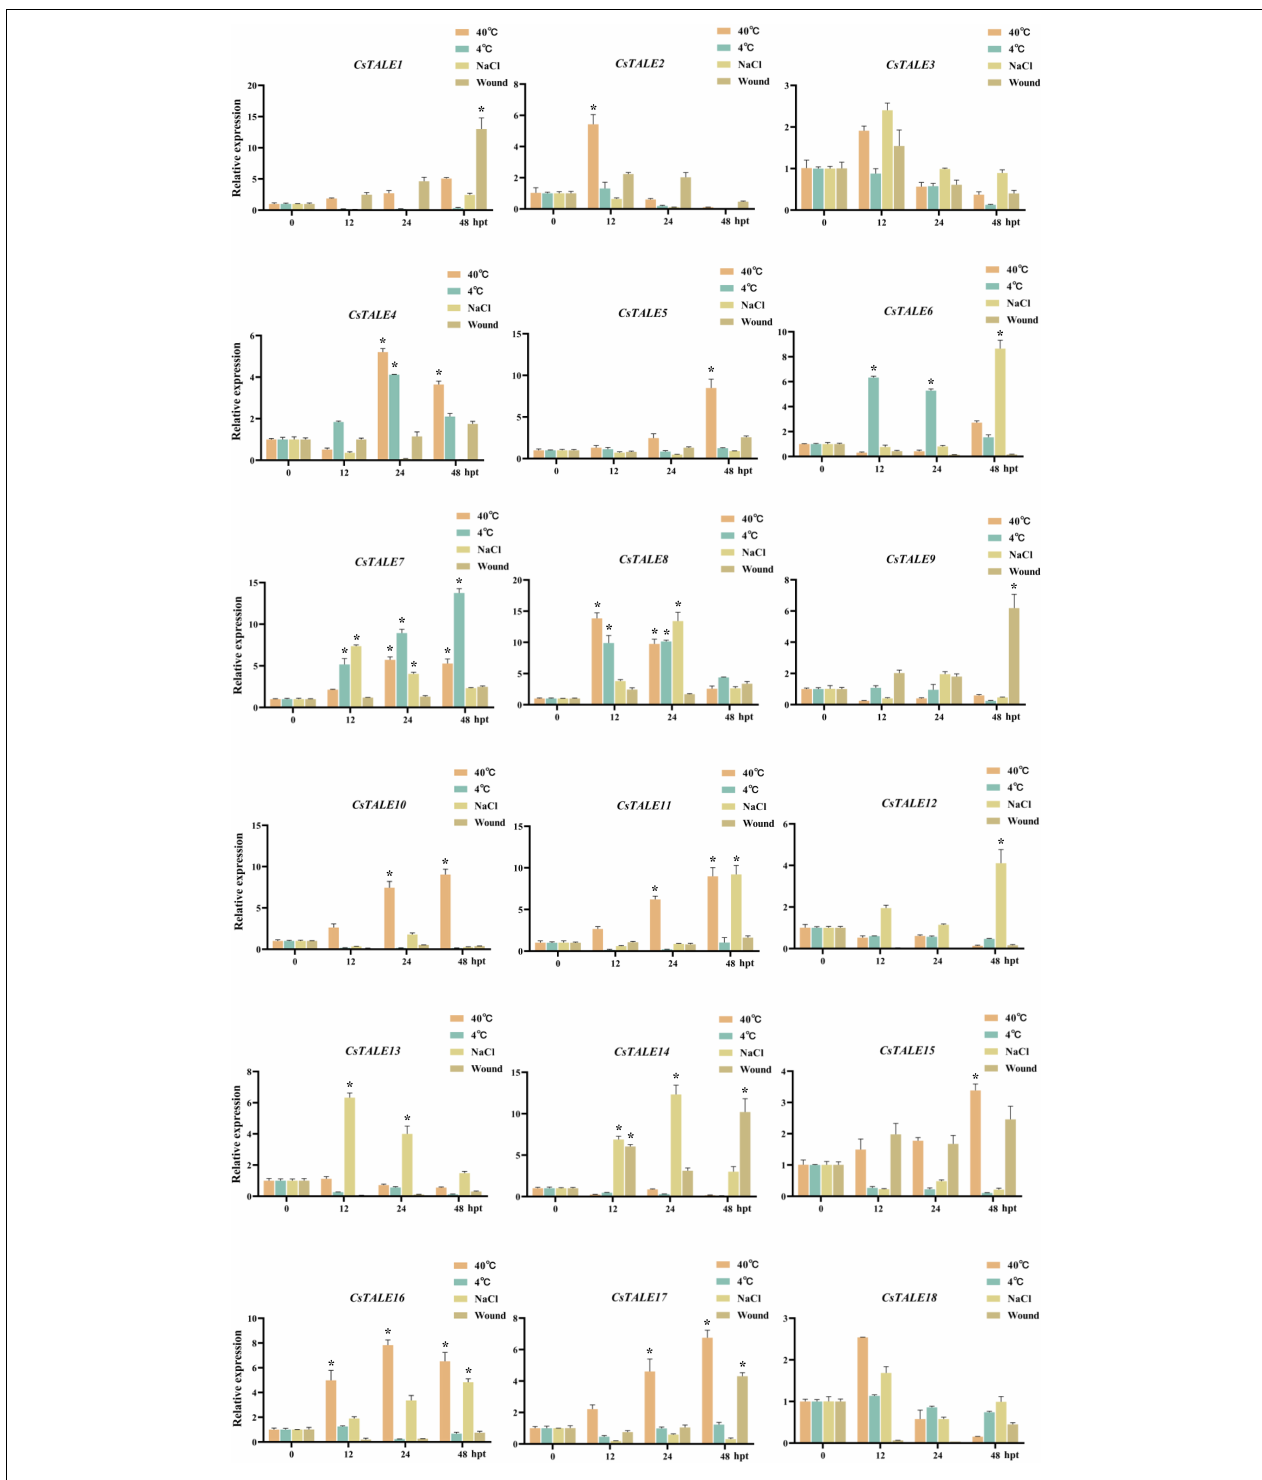
FIGURE 4 | Expression levels of CsTALE genes under different abiotic stress treatment. The Y -axis represent the relative expression level of CsTALE genes and the X -axis indicate different time points post abiotic stress treatment. Different colors represent different stress treatment. The standard errors are plotted using vertical lines. * Represents significant difference ( p < 0.05). The experiments in all panels were repeated three times with similar results.